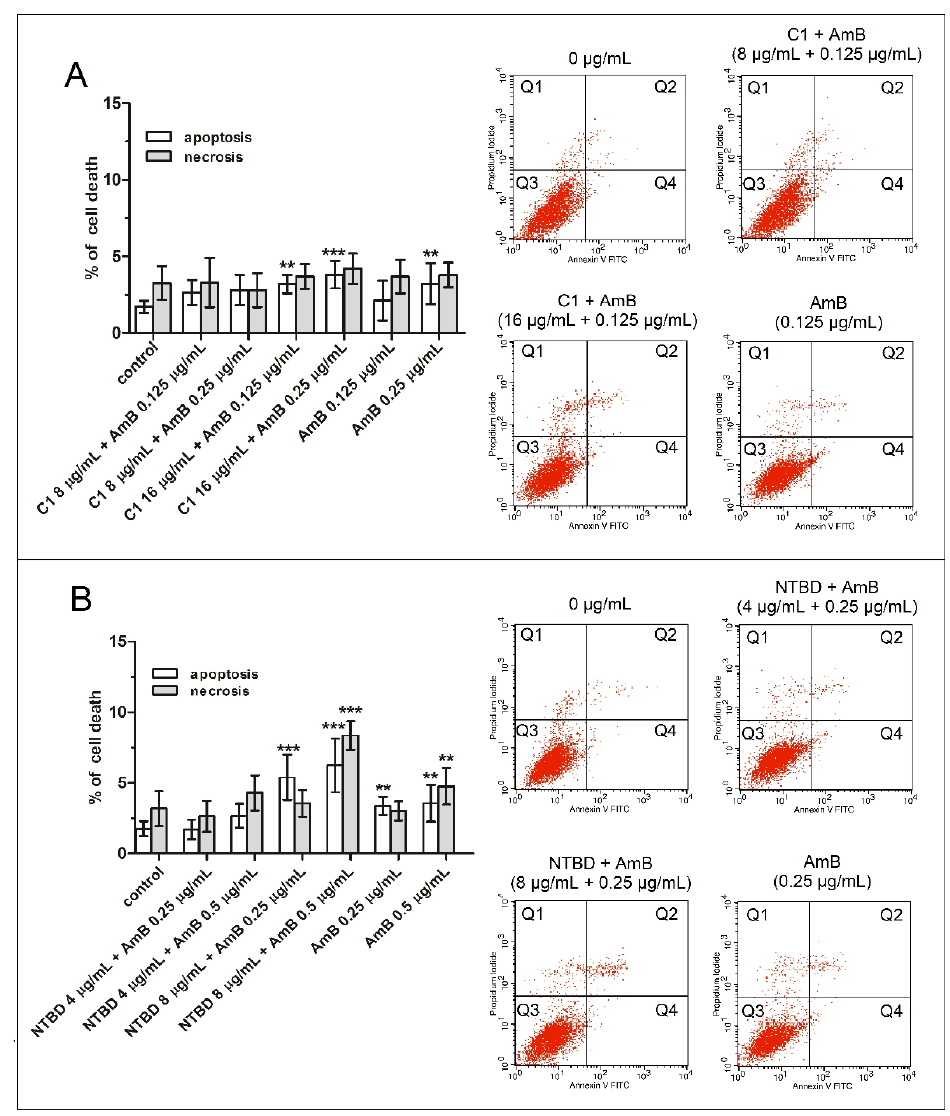
Figure 4. Impact of the combinations of AmB with thiadiazoles C1 ( A ) or NTBD ( B ) on the induction of apoptotic and necrotic cell death in RPTECs. Following the 24 h treatment with or without a mixture of AmB with C1 or NTBD and with each of these compounds alone, the cells were double stained with Annexin-V/PI and analyzed with flow cytometry. Each red dot on the dot plots indicate single event/cell. Bar graphs show quantitative analyses of the percentage of apoptotic (early + late apoptosis) and necrotic cells. Values are significantly different from the vehicle control if p < 0.01 **, p < 0.001 *** in the one-way ANOVA test. Selected histograms from three independent cytometric measurements are presented on the right side of the graphs. Abbreviations: Q1 — An-/PI+ necrotic cells, Q2 — An+/PI+ late apoptotic cells, Q3 — An-/PI- viable cells, Q4 — An+/PI- early apoptotic cells. In the 24-h combined treatment, the administration of AmB (0.125 or 0.25 µg/mL) with 8 µg/mL C1 elicited a negligible proapoptotic response in the RPTEC cell cultures. Moreover, at the higher doses of C1 (16 µg/mL) with AmB, there was no rapid increase in apoptosis, which reached a maximum value of 3.8%. However, compared to the AmB alone treatment, the percentage of apoptosis was slightly higher. Importantly, none of the